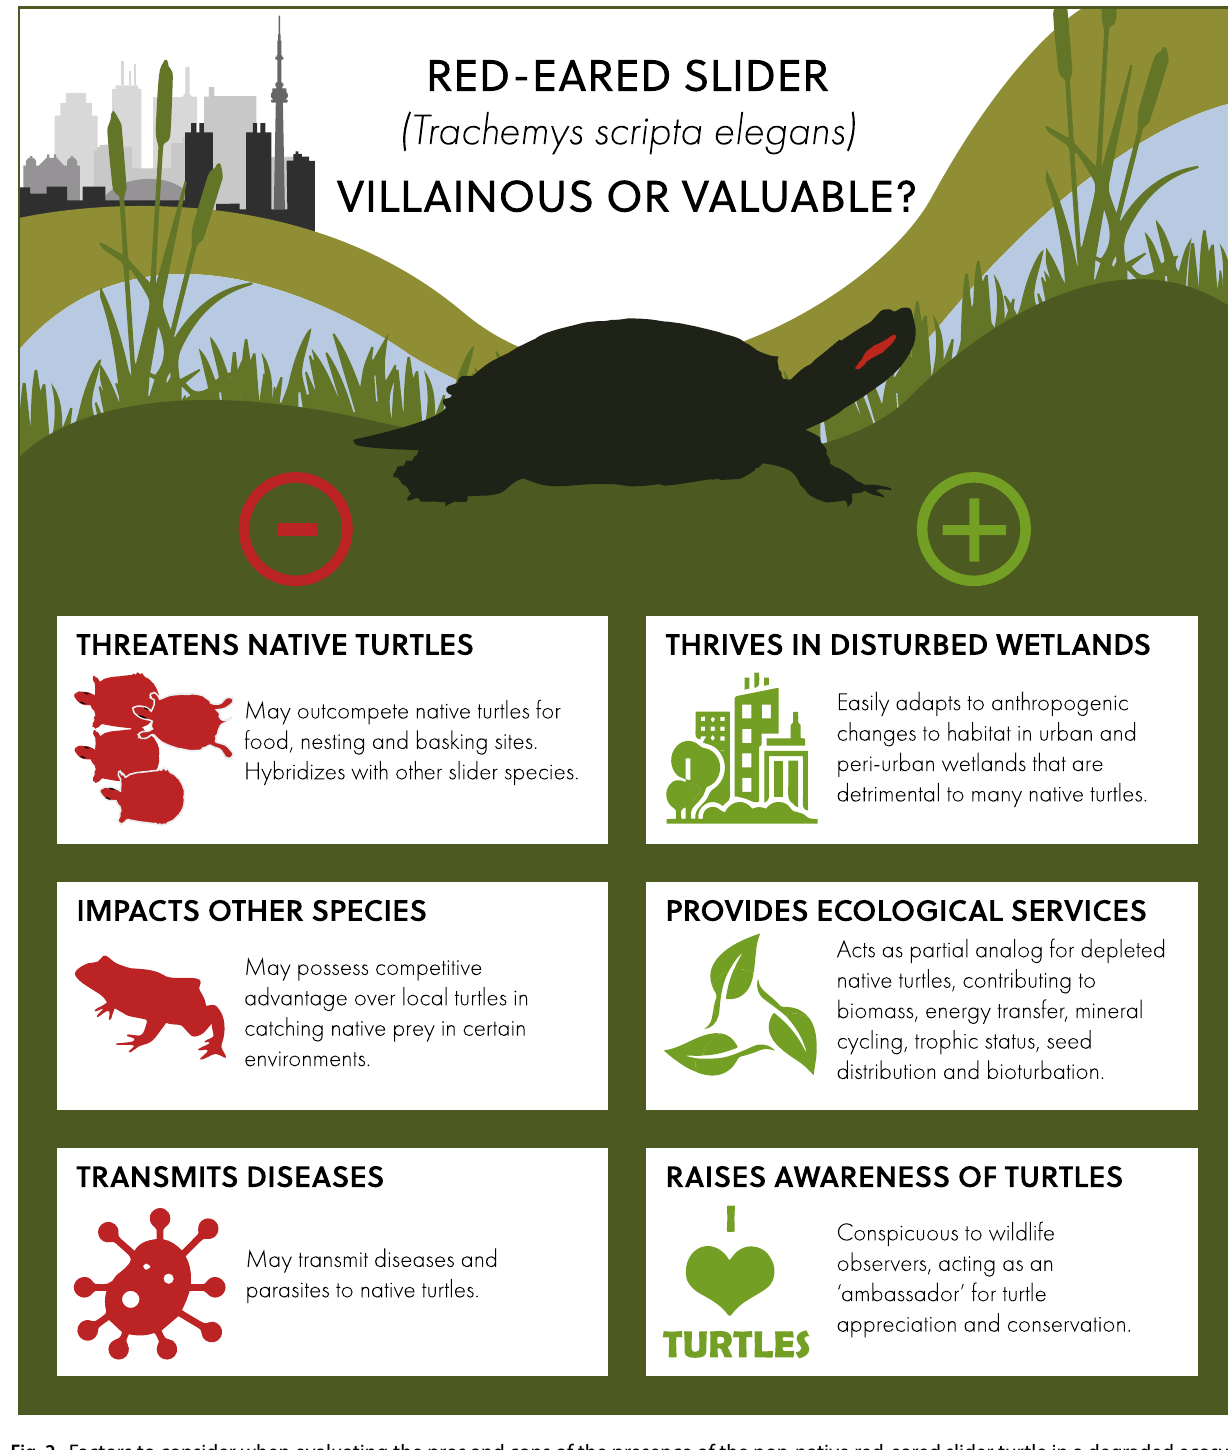
Fig. 2 Factors to consider when evaluating the pros and cons of the presence of the non-native red-eared slider turtle in a degraded ecosys- tem. (illustration Greg